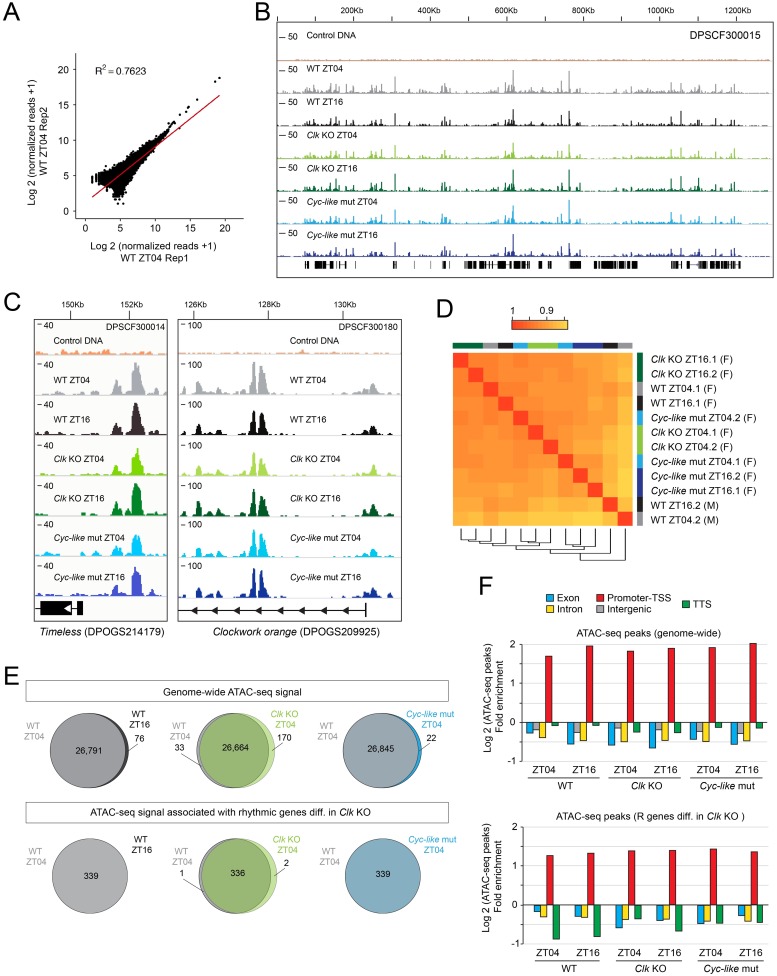
ATAC-seq captures chromatin accessibility in brains of wild-type monarchs and monarchs impaired for clock function.A) Correlation plot of two biological replicates showing normalized read counts in wild-type at ZT04. Correlation plots for all conditions tested are shown in S5A Fig. Correlations varied from 0.76 to 0.85. B) Visualization of ATAC-seq signal between genotypes and time points at scaffold DPSCF300015 showing no substantial gross change in chromatin accessibility in adult brain. ATAC-seq peaks from biological replicates are merged. WT, wild-type; Clk KO, Clk knockouts; Cyc-like, Bmal1 mutants lacking the C-terminal transactivation domain [6]. C) Representative ATAC-seq tracks in genomic regions of clock genes (timeless and clockwork orange) showing the lack of differential ATAC-seq peaks between time points and genotypes. D) ATAC-seq signal within consensus ATAC-seq peaks was compared between all samples using Pearson’s correlation to cluster samples. Replicates are noted as numbers following each genotype and time point. F: female; M: male. E) Venn diagrams representing lack of differences in ATAC-seq signal within consensus genome-wide ATAC-seq peaks (top) and ATAC-seq peaks associated to rhythmic genes differentially regulated in Clk knockouts (bottom) between ZT04 and ZT16 in wild-type brains and between genotypes at ZT04 (fold-change cutoff > 1.3). The complete list of cross-comparisons is provided in S9 Table. F) Log2 fold enrichment of ATAC-seq peaks within different genomic regions in the monarch genome (top) and within rhythmic genes differentially regulated in Clk knockouts (bottom) for each genotype at ZT04 and at ZT16. Except for intergenic regions, genomic features are defined within -1Kb of the transcription start site (TSS) and +1Kb of the transcription termination site (TTS). Fold enrichment is calculated as the number of peaks per genomic regions/total number of peaks relative to the length of the genomic regions/total length.